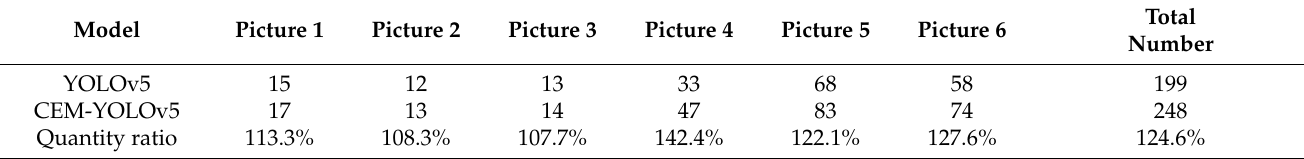
Table 6. Model prediction.